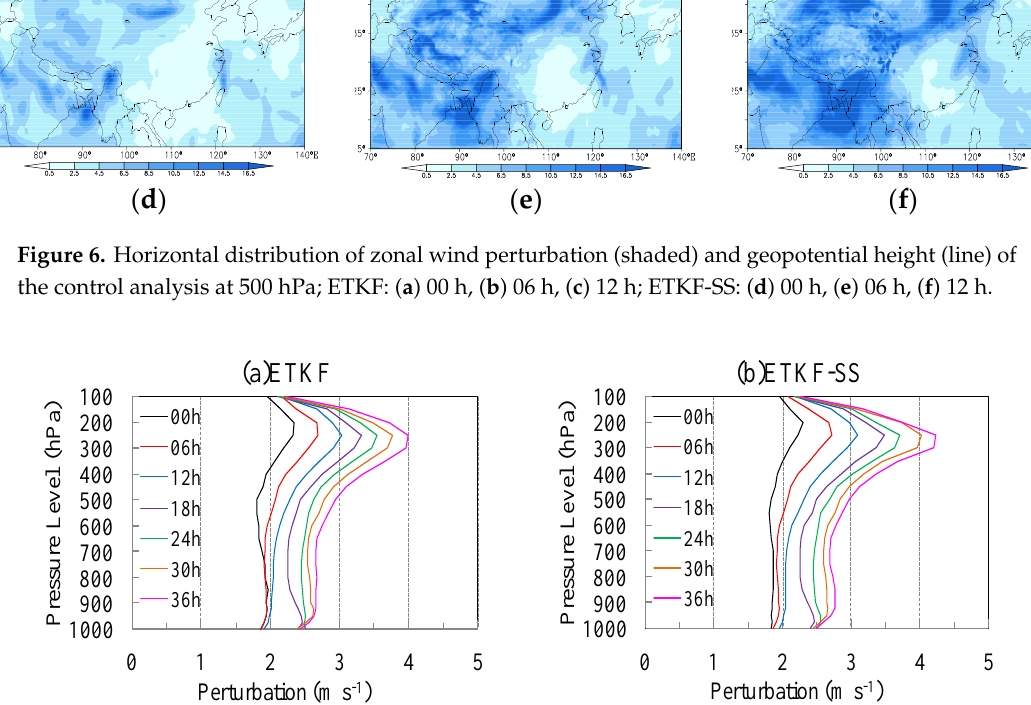
Figure 6. Horizontal distribution of zonal wind perturbation (shaded) and geopotential height (line) of the control analysis at 500 hPa; ETKF: ( a ) 00 h, ( b ) 06 h, ( c ) 12 h; ETKF-SS: ( d ) 00 h, ( e ) 06 h, ( f ) 12 h.